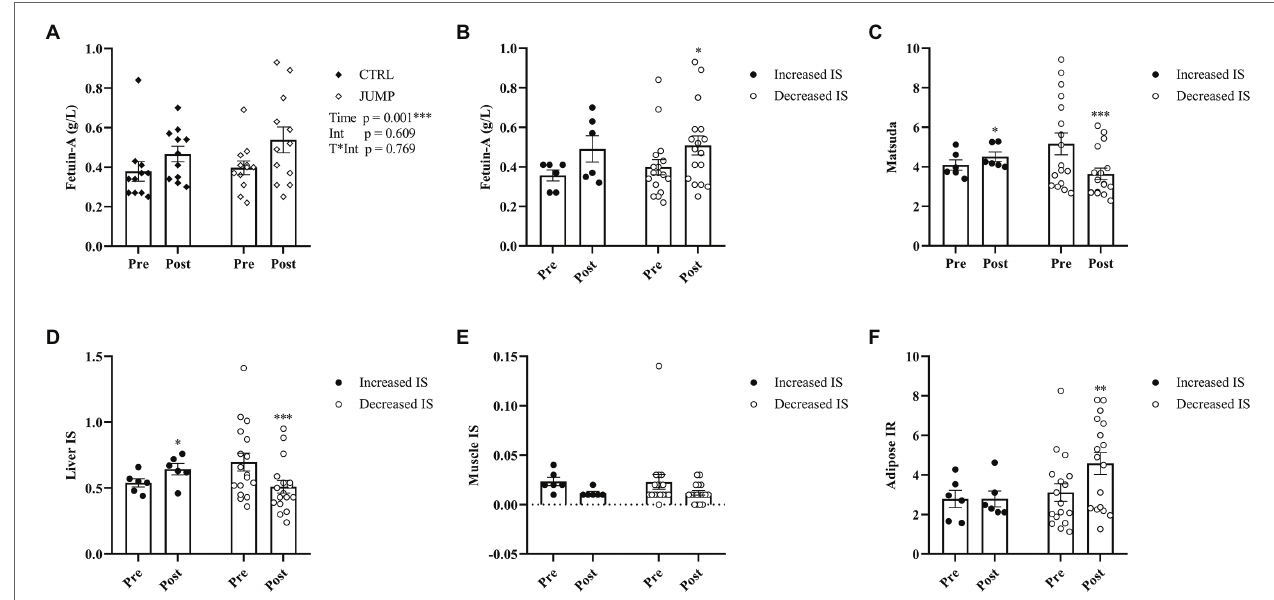
FIGURE 2 | (A) Circulating fetuin-A in the CTRL and JUMP groups before and after 60 days of HDT bed rest. (B–F) The effect of HDT bed rest on fetuin-A and OGTT derived indexes of insulin sensitivity and insulin resistance when subjects were divided into two subgroups based on an increase ( n = 6) or decrease ( n = 17) in insulin sensitivity (Matsuda) post-HDT bed rest. Data are presented as mean ± SEM. Abbreviations: CTRL, control group; JUMP, jumping countermeasure group; IS, insulin sensitivity; IR, insulin resistance; Time, main effect of time; Int, main effect of intervention; T * Int, time * intervention interaction effect. * p ≤ 0.05, ** p ≤ 0.010, and *** p ≤